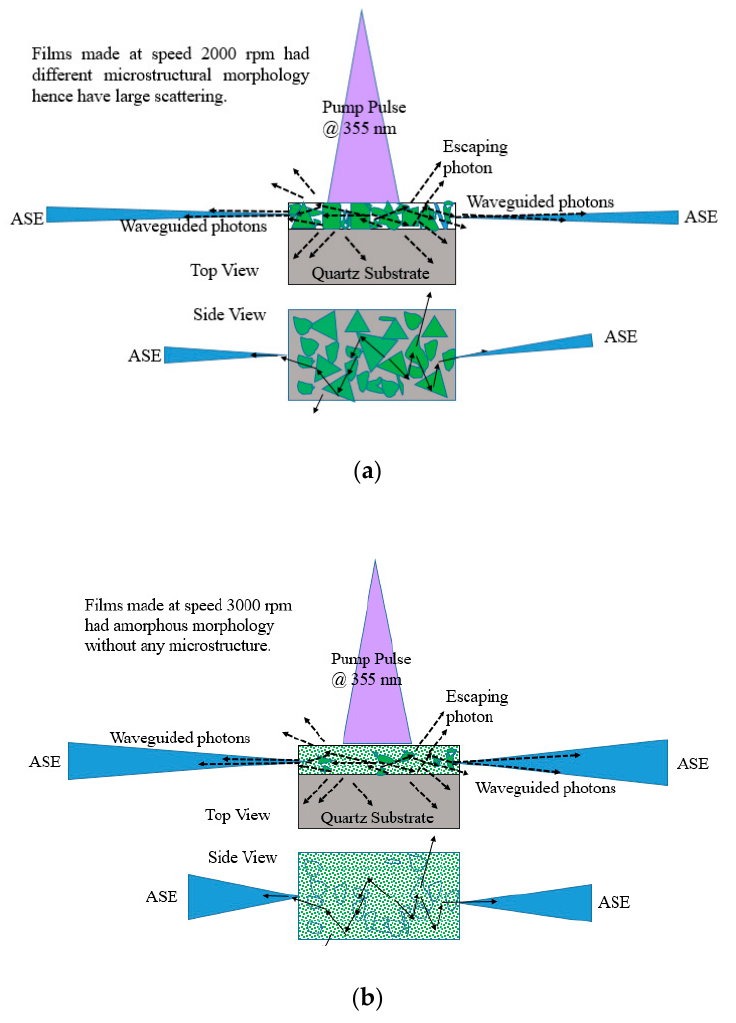
Figure 17. Waveguiding nature of the CO thin films for ( a ) 2000 rpm and ( b ) 3000 rpm. The green shapes in Figure 17a represent different oligomer crystal structures (for 2000 rpm) and green wave in Figure 17b represents amorphous structure. The blue shapes with in the film represent the grain boundaries. The blue cone or triangle in Figure 17a,b represents the ASE beam.